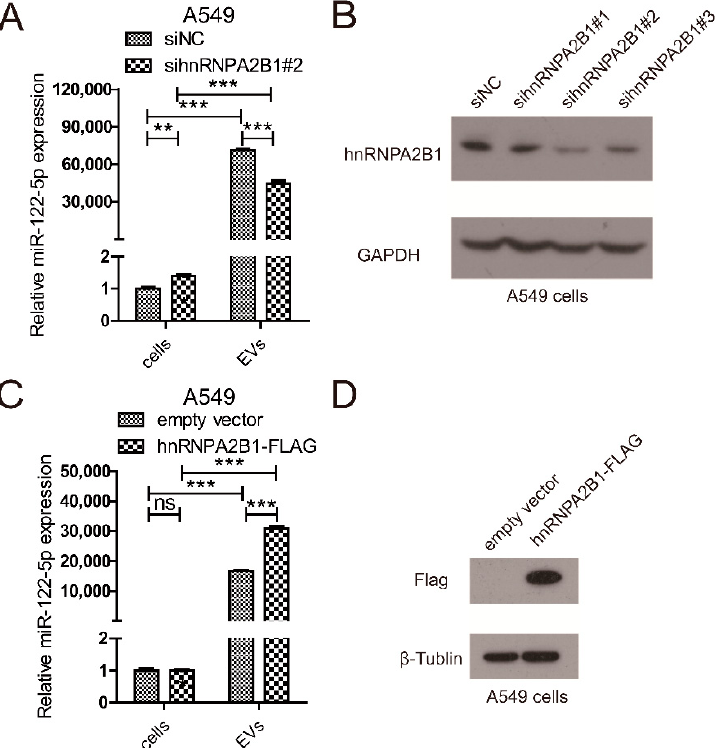
Figure 4. hnRNPA2B1 affects the sorting of miR-122-5p into A549 EVs. ( A ) Expression of miR-122-5p in EVs and cell lysate of A549 transfected with hnRNPA2B1 siRNA or NC siRNA. ( B ) Western blot results show the knockdown efficiency of hnRNPA2B1 siRNA. ( C ) Expression of miR-122-5p in EVs and cell lysate of A549 overexpressed with hnRNPA2B1-flag plasmid or empty vector. ( D ) Western blot results show the overexpression of hnRNPA2B1 using anti-flag antibody. Three independent experiments were performed, and the statistical analyses were performed with the Student’s t test. Ns: no significance, **: p < 0.01, ***: p < 0.001.